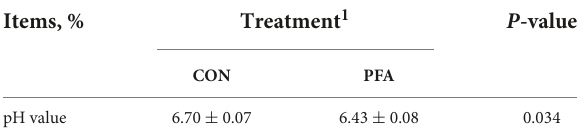
TABLE 1 Effect of dietary paraformic acid supplementation on pH values of cecal digesta in broiler chickens. Items, %